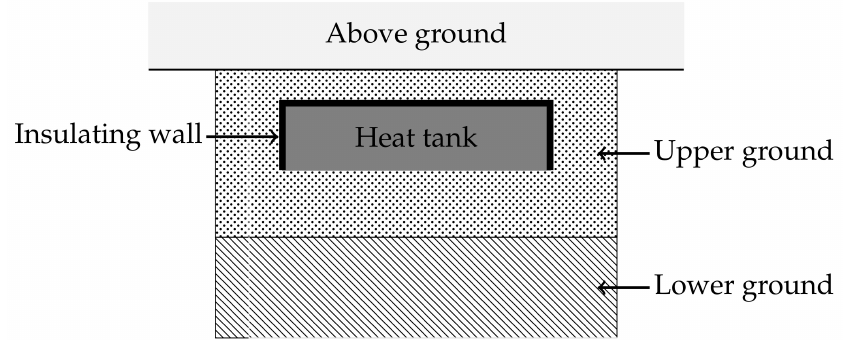
Figure 2. Cross-section as a schematic representation of a 3D-GES. The upper ground often has different properties than the lower ground. The heat tank is filled with upper ground, includes a heat source/sink and is downwardly open. Accordingly, the heat flows into the tank from below or inversely. Each interface exhibits different transition properties that need to be modelled into the heat flow